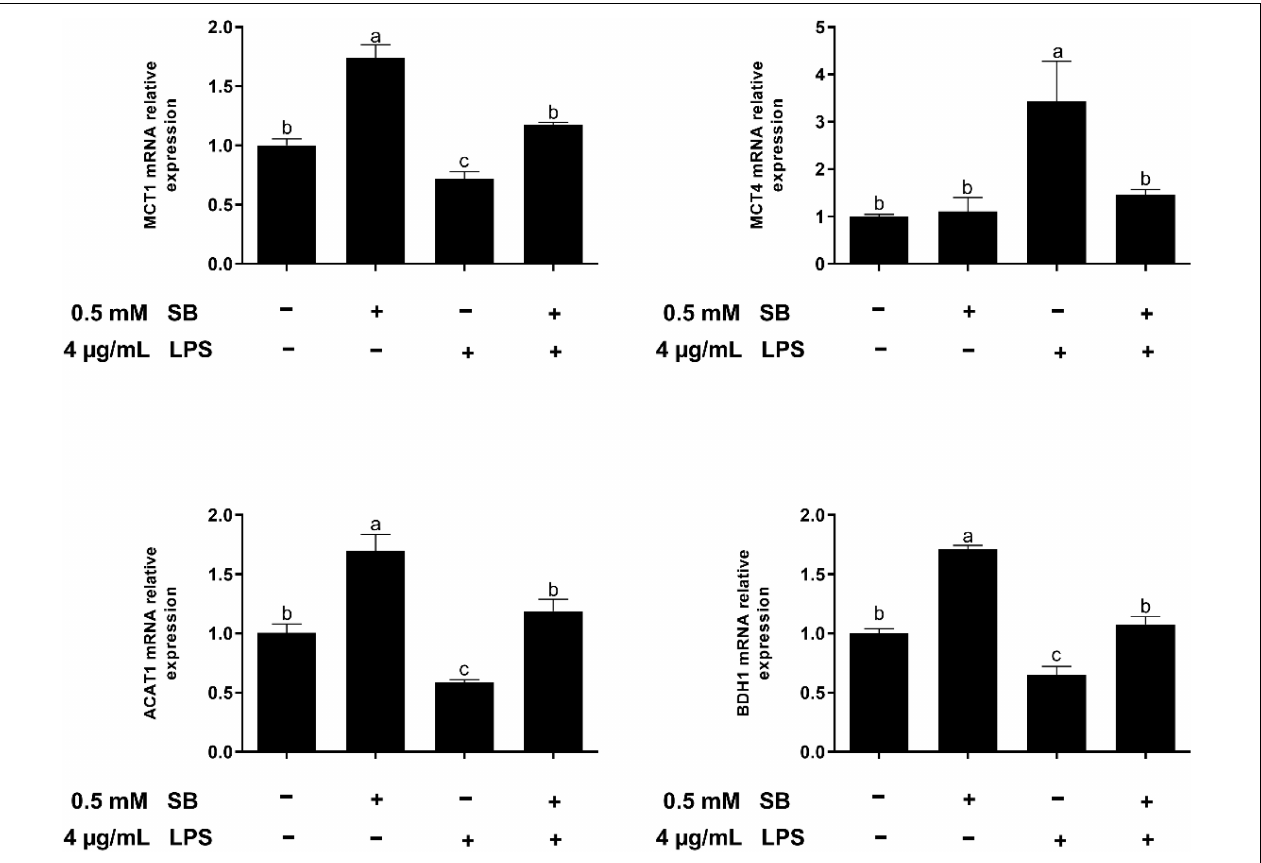
FIGURE 5 | The effect of SB on the expression of genes involved in SB uptake and metabolism in BRECs stimulated with LPS. BRECs were pretreat with SB (0.5 mM) for 18 h followed by stimulation with LPS for 6 h. After incubation, cells were analyzed by qRT-PCR. The values are shown as mean ± SEM ( n = 3). The letters in superscript indicate that the difference between groups was significant ( P <